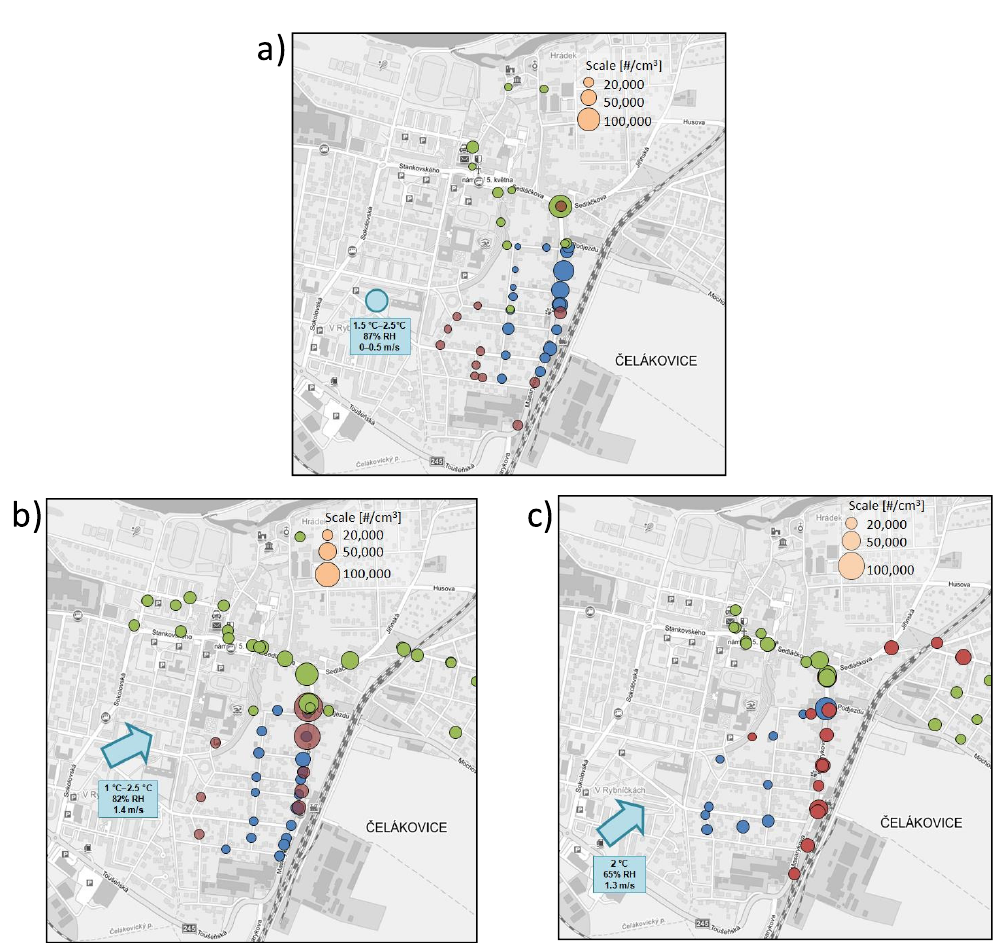
Figure 14. Simultaneous particles number concentration measurements with two mobile apparatuses. Dot colors indicate time intervals. The first apparatus measured closed to a main road while the second measured parallel away from the main road. Concentrations along main roads were elevated in comparison with places further from the road. ( a ) Particle number concentrations 30 January; simultaneous measurement at 7:30–8:00 a.m.